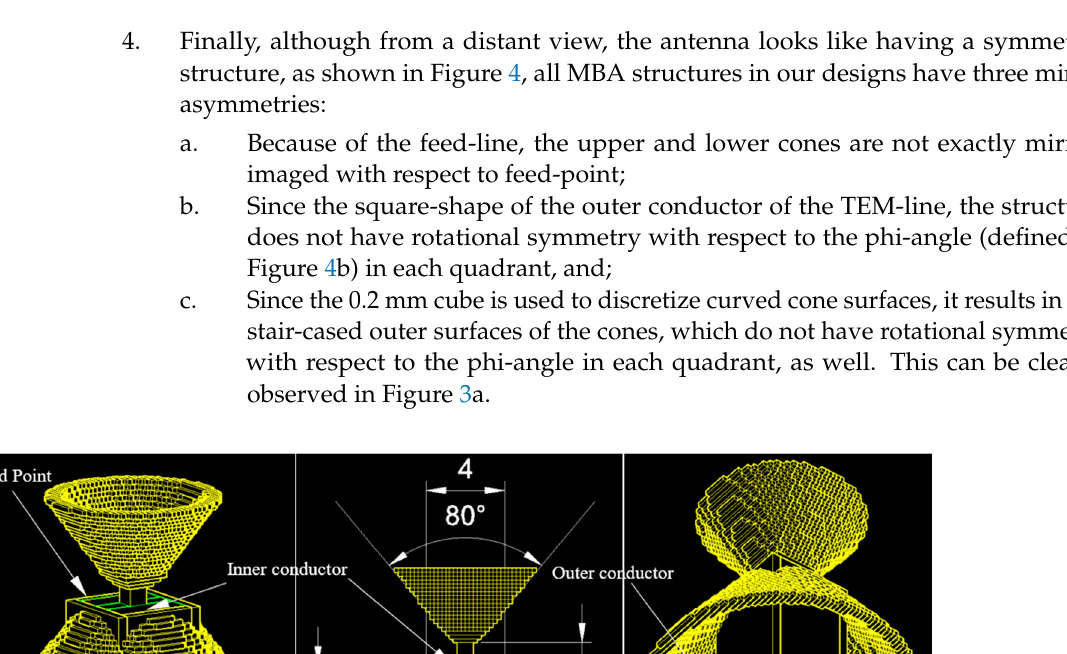
(cid:42) R and the white-dashed